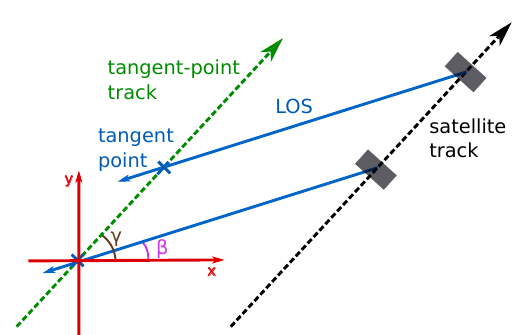
Figure 3. Global observation geometry of an exemplary orbit of (a) SABER and (b) HIRDLS. Satellite positions are shown by green dots and corresponding tangent points by red triangles. The thick purple line represents an exemplary LOS, while blue arrows show the flight direction. For details, see text.